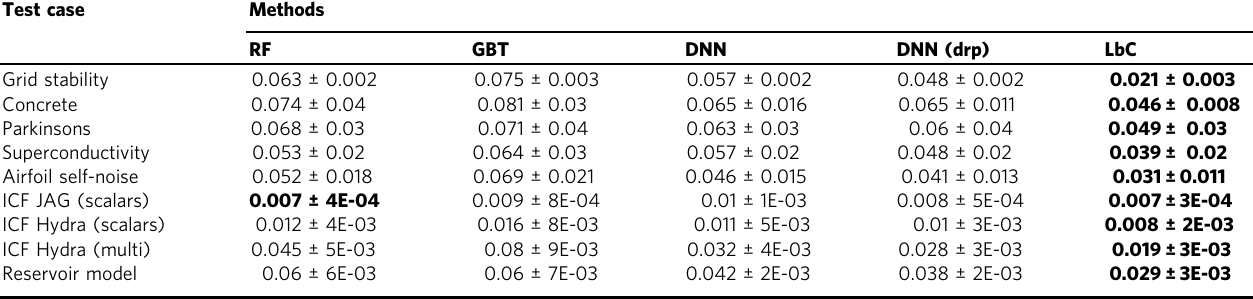
Table 2 Surrogate model performance evaluation using root mean-squared error.